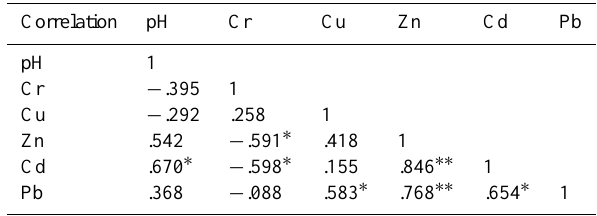
Table 4. The results of the Pearson correlation analysis between the different measured